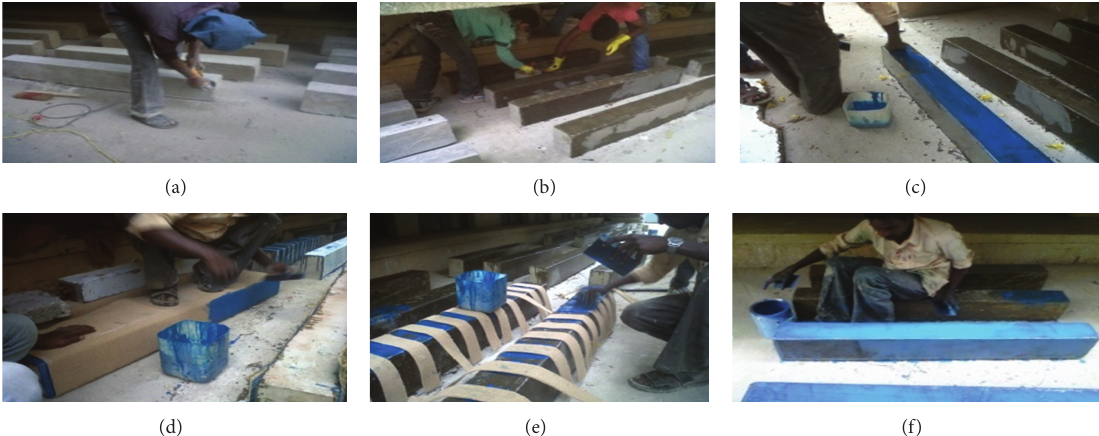
Figure 5: (a) Surface preparation of beams by grinding; (b) primer application on beam surface; (c) application of epoxy-hardener mix on the beam; (d) bonding of woven jute; (e) bonding of woven jute in strips; (f) final coating of epoxy-hardener mix on the bonded